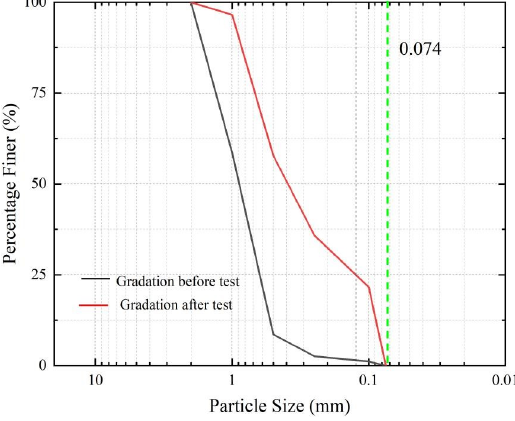
Figure 18. Hardin’s breakage potential model. Samples in test groups with effective confining pressures of 60 kPa and 100 kPa were selected for drying and particle screening, resulting in particle gradation curves for different numbers of loading cycles. According to Table 3 and Figure 19, calcareous sand samples show obvious particle breakage after cyclic tests with smaller CSR values and the relative breakage tends to be negligible when CSR reaches a certain value. Table 3. Relative breakage rate B r .